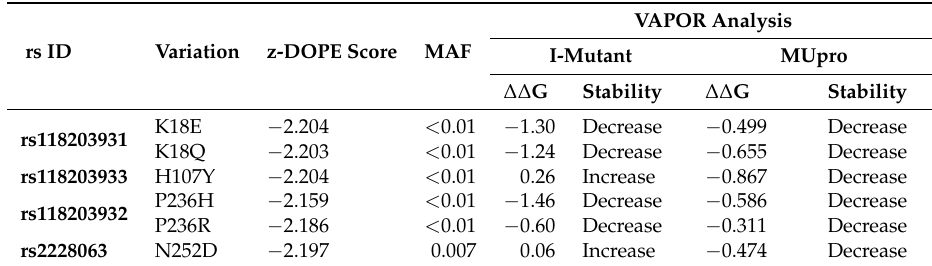
Table 1. α -CA-II single SNVs rs IDs, associated residue-variant substitutions, model z-DOPE score, MAF and predicted variant consequences. Global MAF obtained from gnomAD.